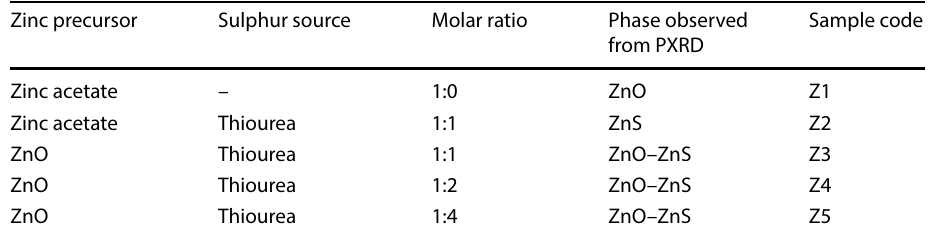
Zinc precursor Sulphur